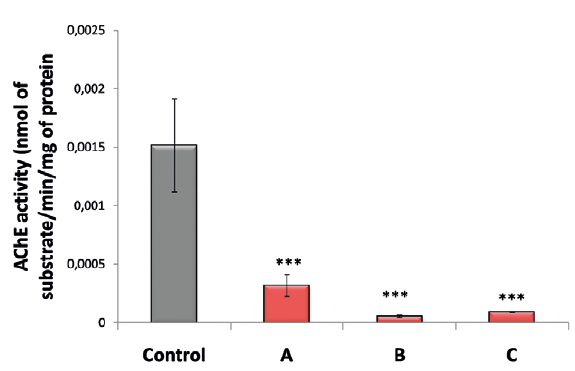
Fig. 1. – AChE activity in Mactra stultorum gills of control and specimens treated with graded doses of ACR (5, 10 and 20 mg L –1 ) after fivedays of treatment. Values are expressed as means ±SD, n=8. A, B, C groups vs. Control group: *** p<0.001.